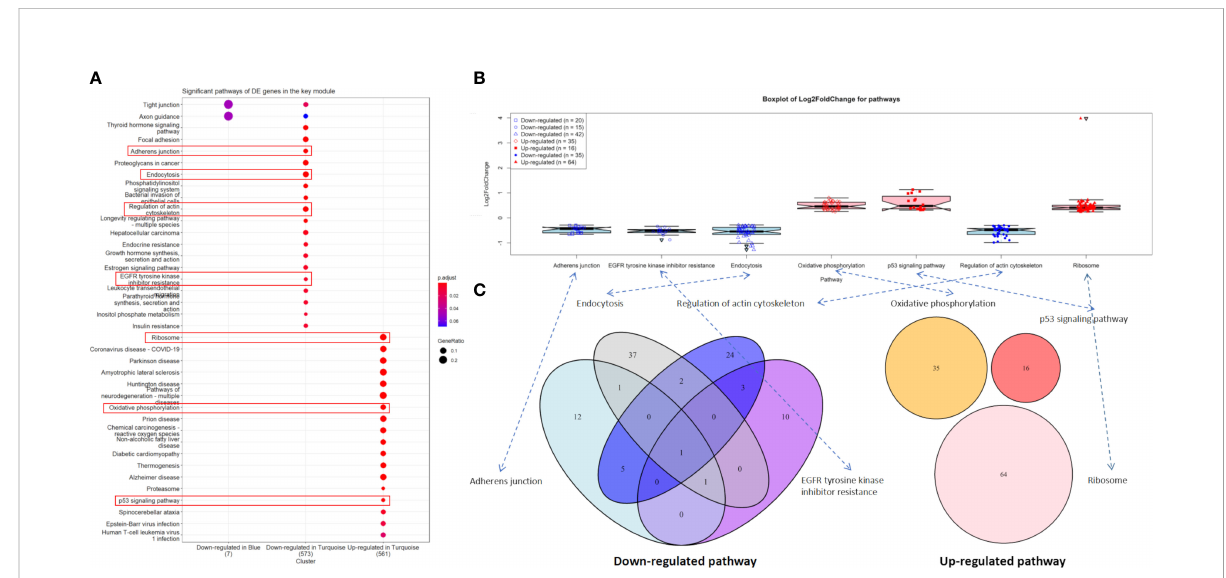
FIGURE 4 Signi fi cant pathways. (A) Signi fi cant pathways for differentially expressed (DE) genes in the turquoise ( n = 2,509) and blue modules ( n = 141) under the downregulated and upregulated categories. (B) Boxplot of log 2 (FC) values for endocytosis and p53 signaling pathway. (C) Venn diagram for the enriched DE genes of four downregulated and three upregulated